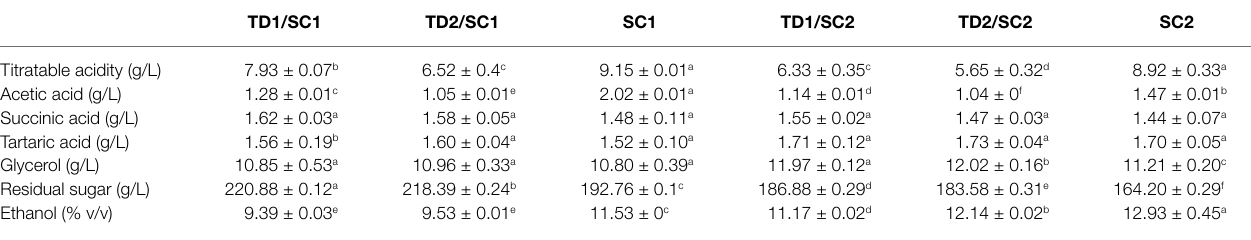
TABLE 1 | The main chemical compositions in mixed and pure culture fermented icewines. TD1/SC1 TD2/SC1